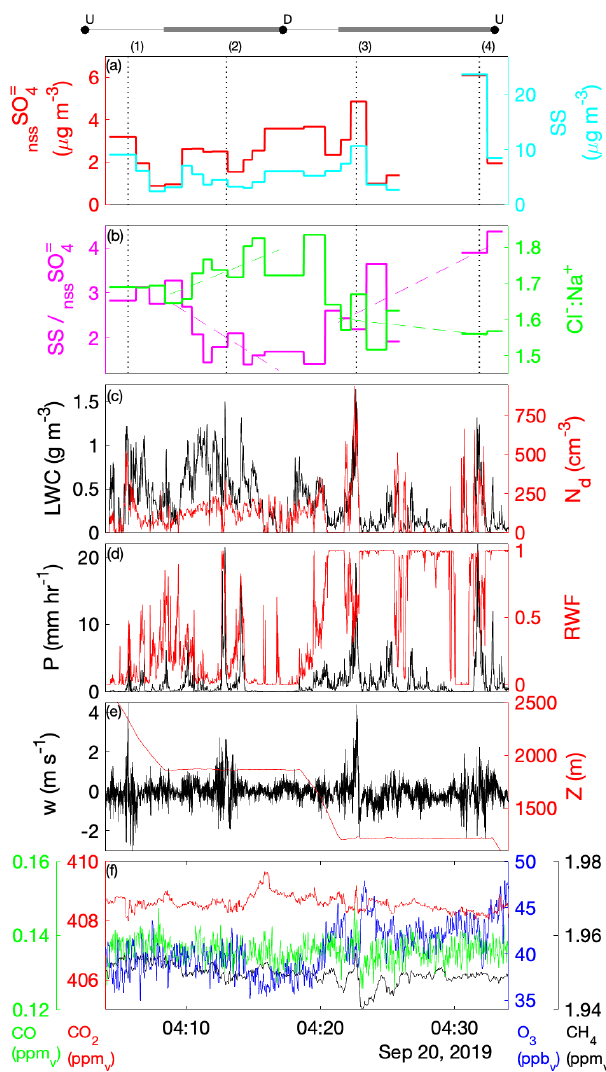
Figure 10. Time series of two mid-cloud levels flown during Case I, containing a high density of cloud water samples (20). The key at the top indicates when the aircraft was at the upwind ( U ) and down- wind ( D ) extents of the cloud module and when on level legs (bold) – note that, unconventionally, descents between levels were not co- ordinated with the U and D turns. Panels show (a) CW nss SO 2 − 4 and SS mass concentration; (b) CW SS: nss SO 2 − and Cl − :Na + 4 mass ratios; (c) LWC and N d ; (d) P and RWF; (e) vertical veloc- ity ( w ) and aircraft altitude ( Z ); (f) gas tracers (CO, CO 2 , CH 4 and O 3 ). Also shown are four transects through convectively enhanced regions (dotted line in panels a and b ) and the linear trends in the ratios during the level leg sections (b)